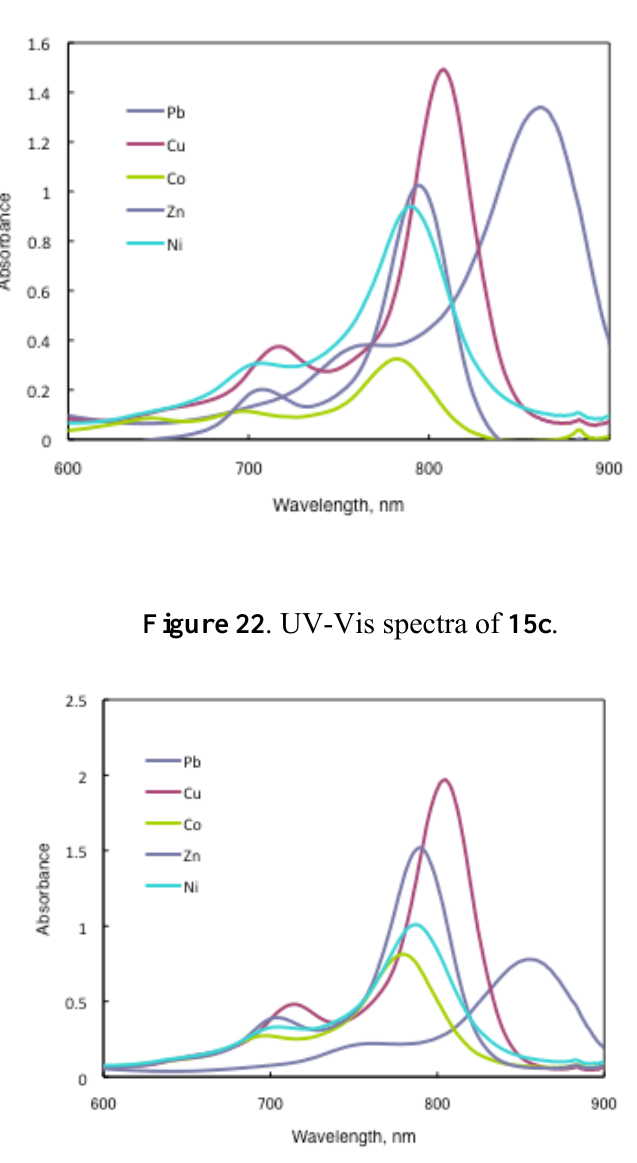
Figure 21 . UV-Vis spectra of 15b .